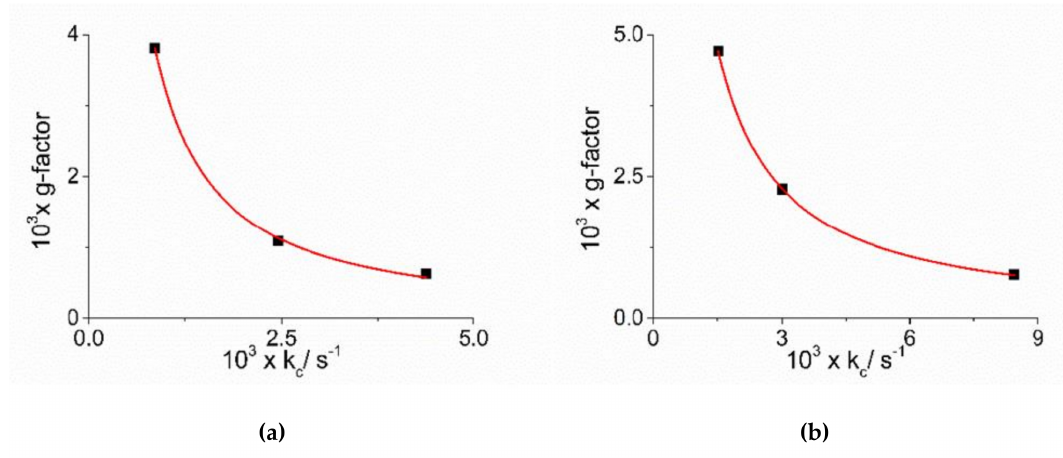
Figure 7. Plot of dissymmetry g -factor versus the catalytic rate constants k c for J-aggregates obtained in the presence of the complex metal ions [Co(phen) 3 ] 3+ ( a ) and [Co(NH 3 ) 6 ] 3+ ( b ). The red line represents the non-linear fit of data to the equations: g = α × k c β ([Co(phen) 3 ] 3+ : α = (1.07 ± 0.37) × 10 − 6 , β = − (1.16 ± 0.05), R 2 = 0.99824; [Co(NH 3 ) 6 ] 3+ : α = (4.73 ± 0.34) × 10 − 6 , β = − (1.06 ± 0.01), R 2 =